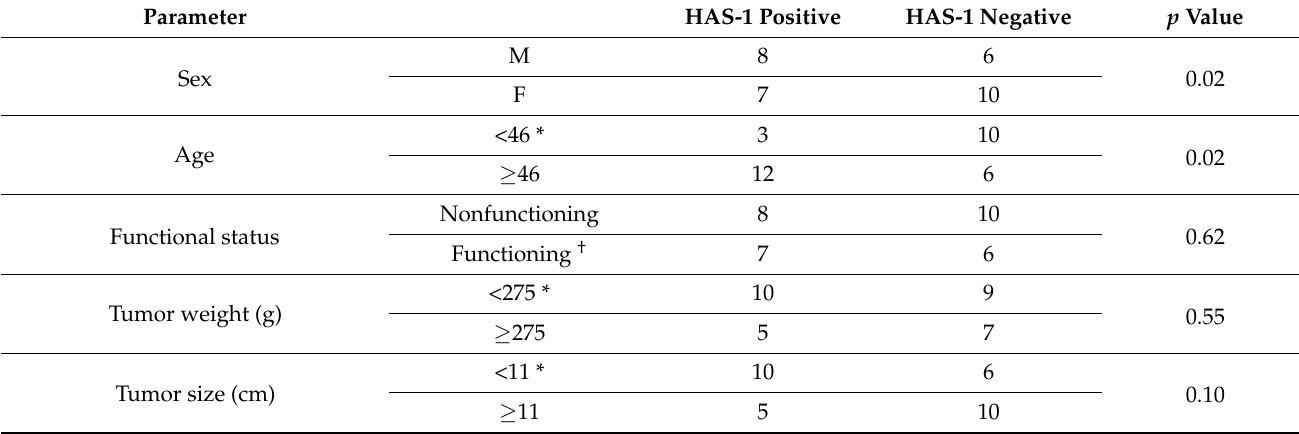
Table 3. Major clinico-pathological features according to HAS-1 positivity in tumor cells (#31 cases on whole section). Parameter